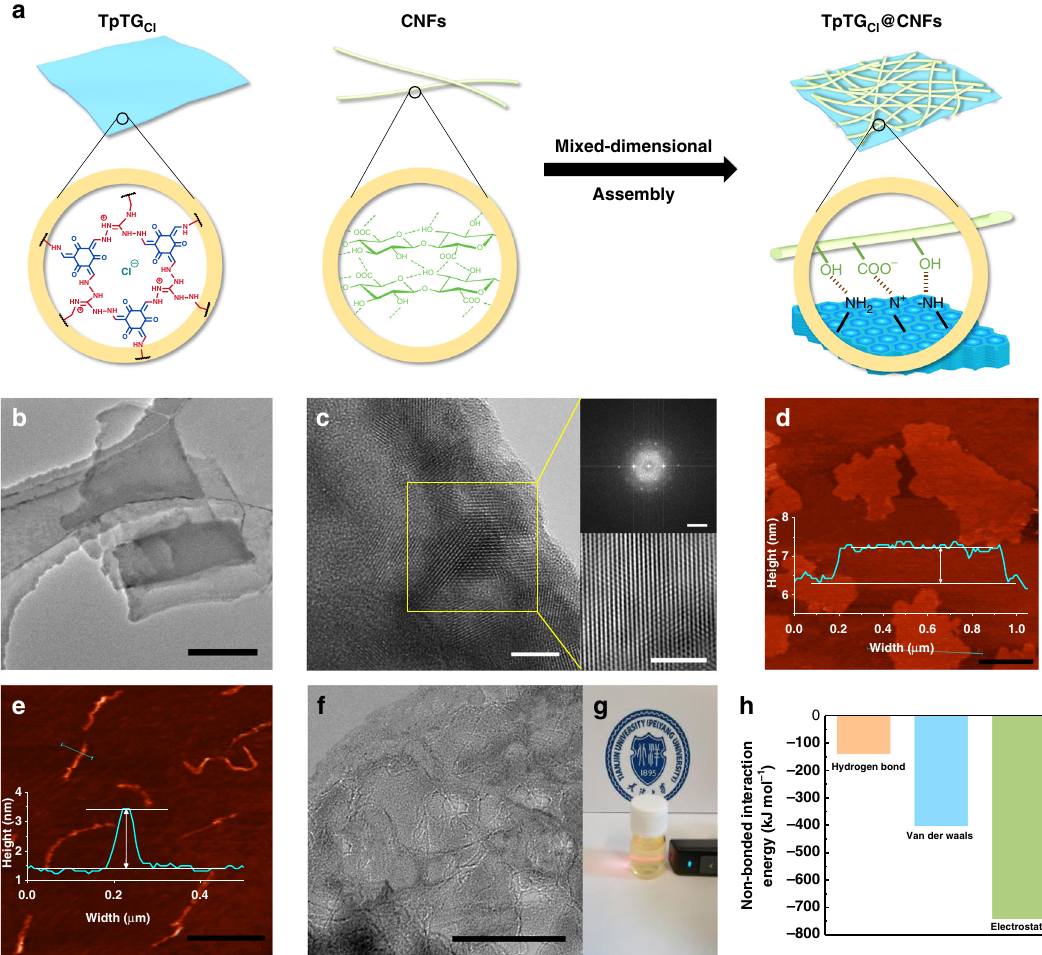
Fig. 1 Mixed-dimensional assembly of TpTG Cl and CNFs. a A schematic illustration showing the assembly process and the interactions. b TEM image of TpTG Cl (scale bar, 500 nm). c HRTEM image of TpTG Cl (scale bar, 5 nm) with FFT (top-right, scale bar, 2 nm -1 ) and IFFT images (bottom-right, scale bar, 5 nm). d AFM image and height pro fi le of TpTG Cl (scale bar, 500 nm). e AFM image and height pro fi le of CNFs (scale bar, 1 μ m). f TEM image